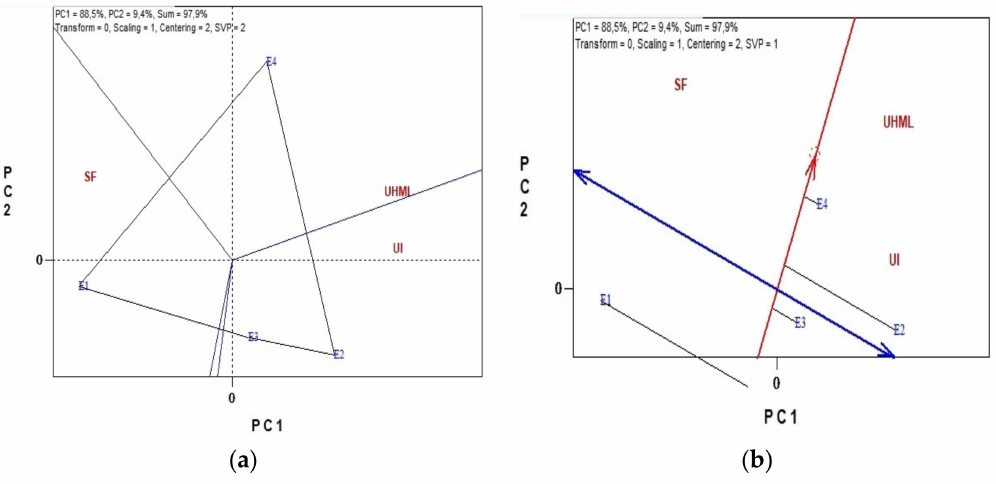
Figure 2. ( a , b ). Biplot analysis of upper half mean length (UHML), uniformity index (UI) and short fiber index (SF), cotton quality measurements across four